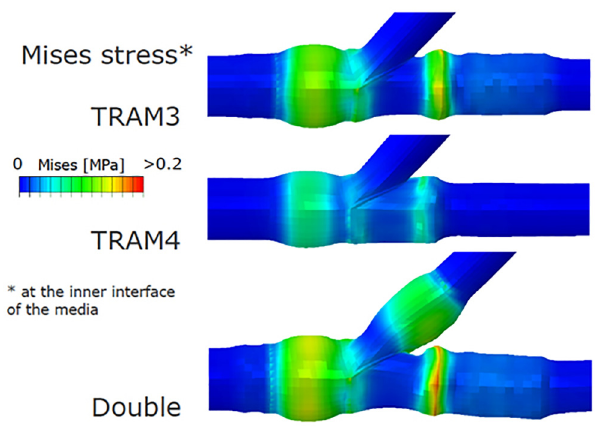
Fig 6. The results of the von Mises Stress on the coronary wall after deployment of the stent with 3 and 4 connecting links and after double stenting.